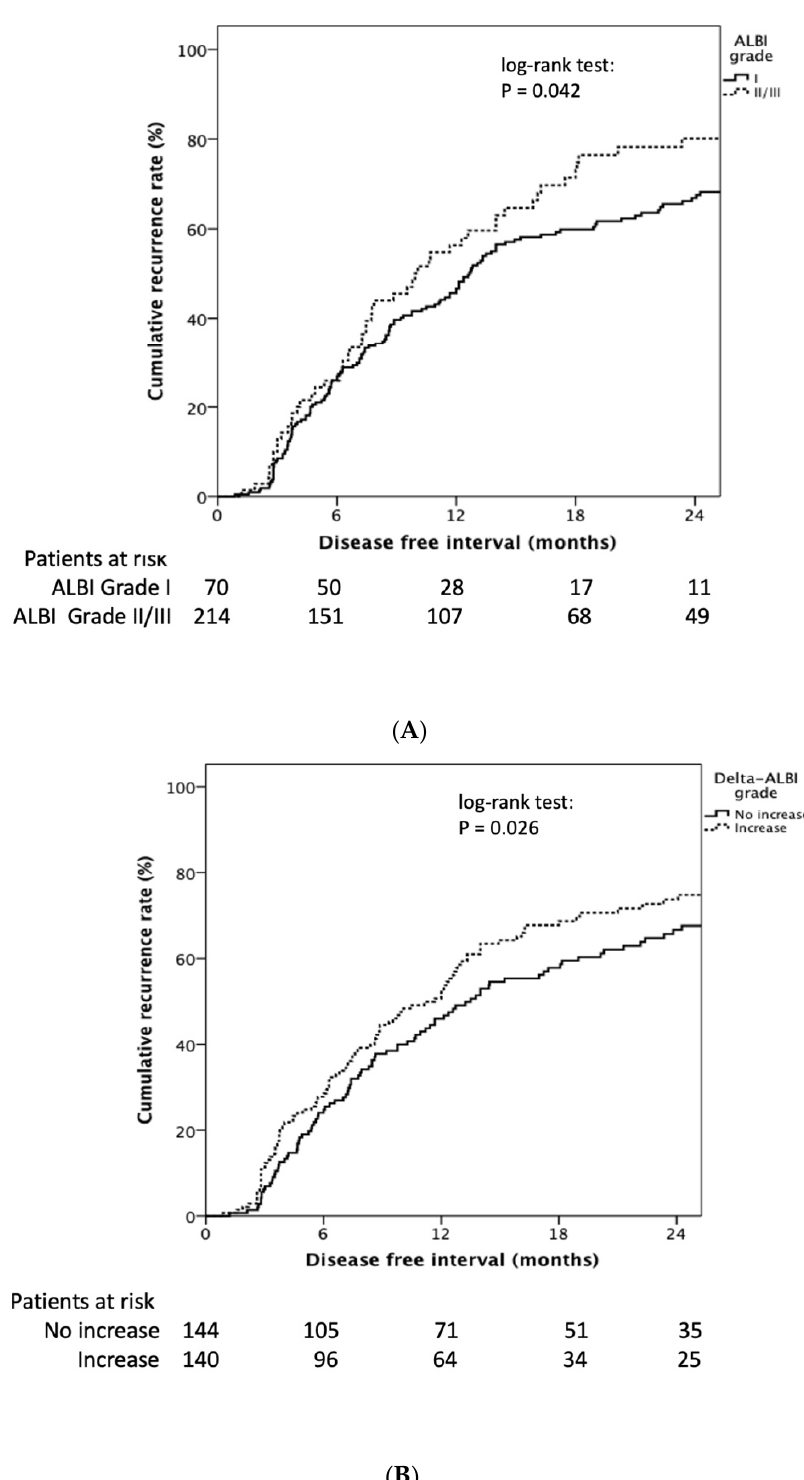
Figure 3. Kaplan–Meier estimates of recurrence rate stratified by ALBI grade and delta ALBI grade. ( A ) Patients with baseline ALBI grade I had longer RFI than grade II and III (median 12.7 (95% CI: 11.2–14.2) vs. 9.9 (95% CI: 6.3–13.6) months, log rank p = 0.042). ( B ) Patients encountering an ALBI grade increase after the first TACE treatment showed significantly decreased RFI compared to those who had the same or a decreased ALBI grade (11.7 (95% CI: 8.9–14.4) vs. 13.5 (95% CI: 10.6–16.4) months, log rank p =